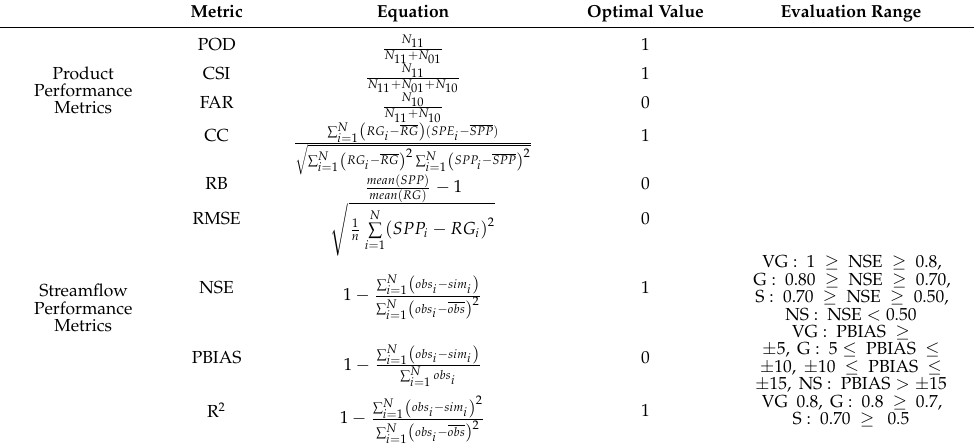
Table 3. Performance metrics for evaluating precipitation and hydrological